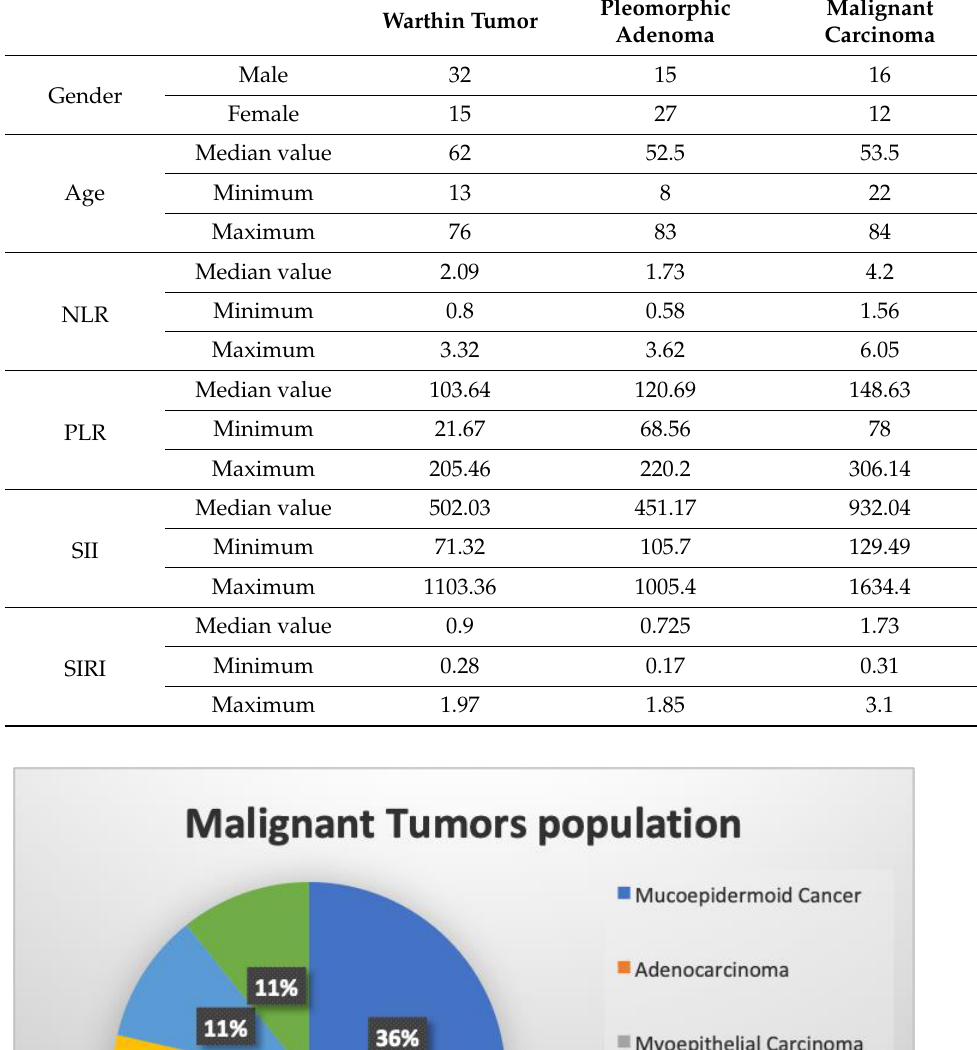
Table 1. Patient characteristics and median values and ranges of clinical parameters.